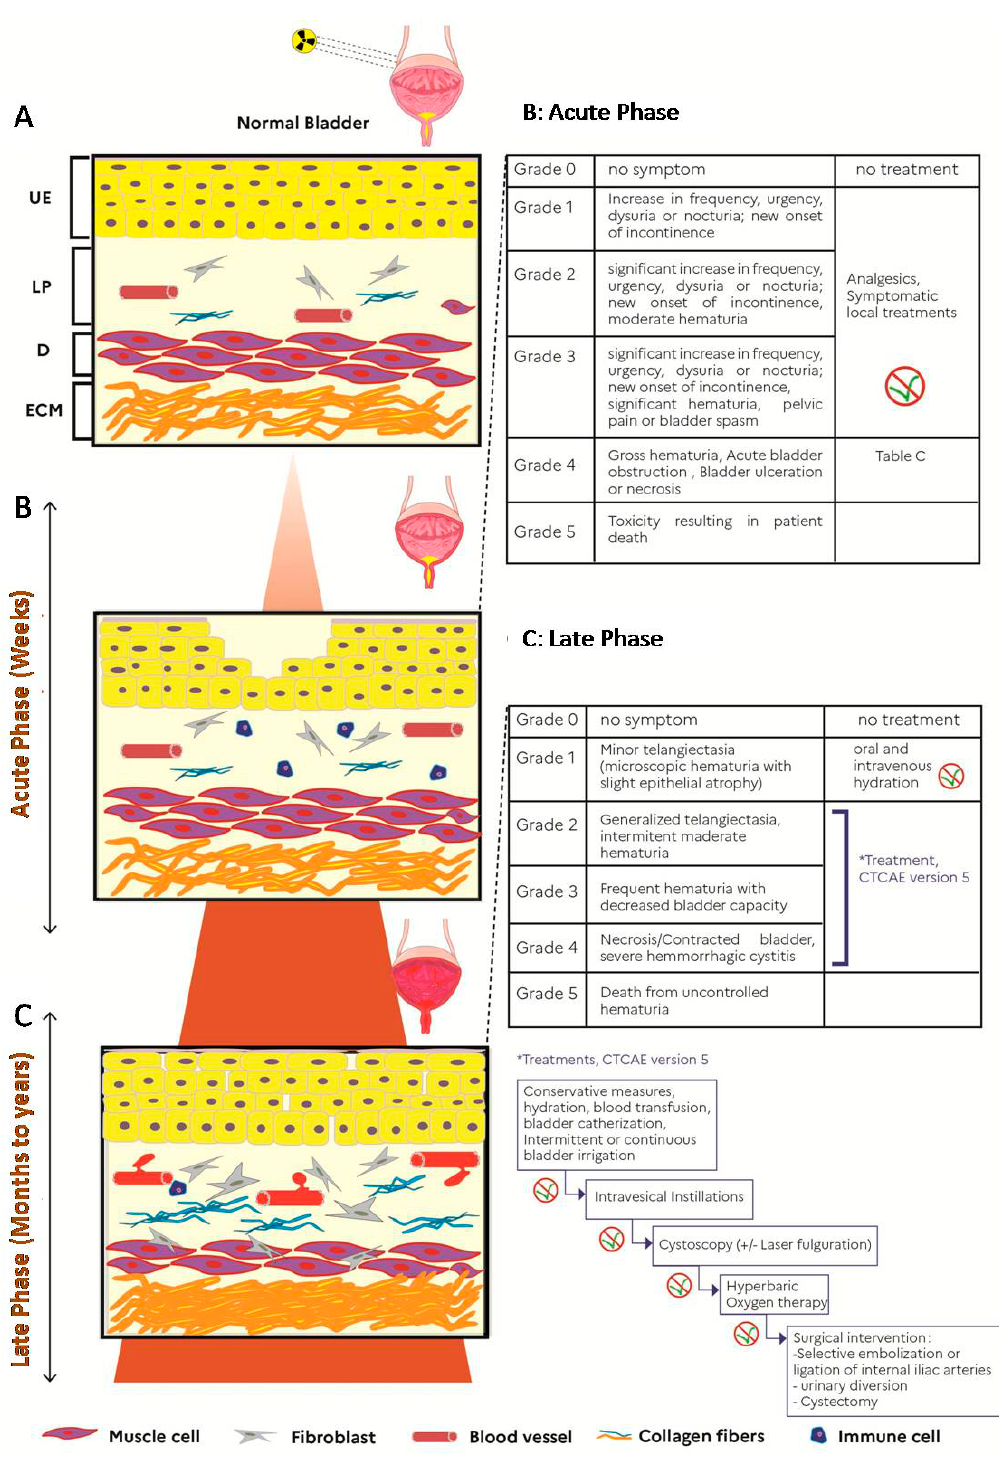
Figure 1. Illustration of radiation cystitis (RC) and clinical management adapted with “Modeling and treatment of radiation cystitis [7], development of RC after radiotherapy ( A ), in the acute phase (infiltration of immune cells into the lamina propria (LP) and depletion of the urothelium (UE)), in latent phase (proliferation of fibroblasts with hematuria, dilation of vessels, bleeding, decrease in the detrusor muscle layer (D) and production of collagen in LP and extracellular matrix(ECM). (F: fibroblast, V: vessel, M: muscle cells, C: collagen fibers, I: immune cells) ( B ) Clinical management during the acute phase of CR. ( C ) Clinical management during the latent phase of CR. * corresponds to cascade treatments of grades 2 to 4 according to CTCAE version 5